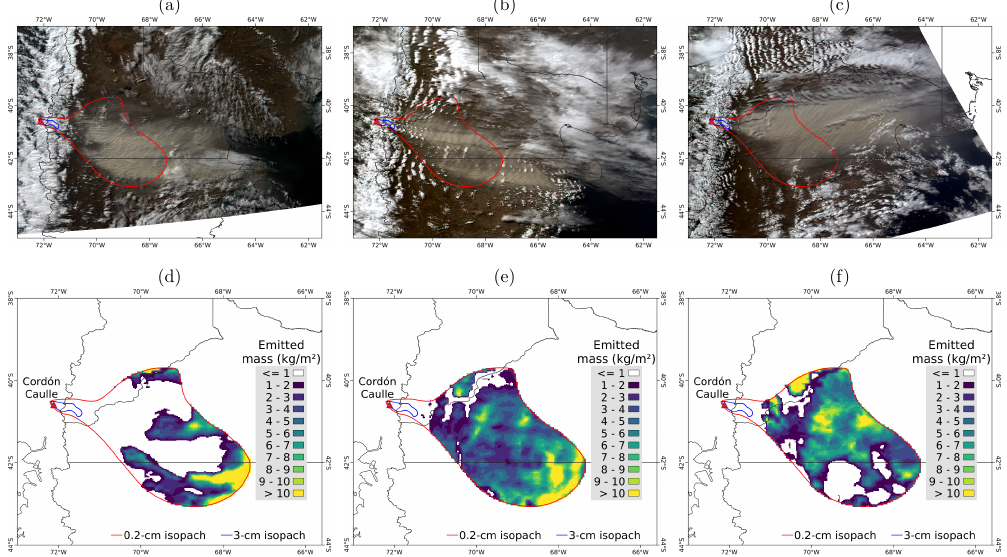
Figure 11. Ash resuspension over the Patagonian steppe detected by MODIS on: ( a ) 29 August 2011 at 18:15 UTC, ( b ) 24 September at 18:50 UTC and, ( c ) 15 October at 19:10 UTC. Bottom plots show the model emitted mass per unit area during ( d ) 27 August 00:00 UTC–30 August 00:00 UTC, ( e ) 24 September 00:00 UTC–26 September 00:00 UTC, and ( f ) 14 October 12:00 UTC–18 October 00:00 UTC. The external limit of the emission source area is defined by the 0.2-cm isopach of the primary tephra-fallout deposit (solid red line). This area is subdivided into two areas: a proximal area limited externally by the 3-cm isopach (solid blue line) and a distal area between the blue and red contours (see Figure 2 for more